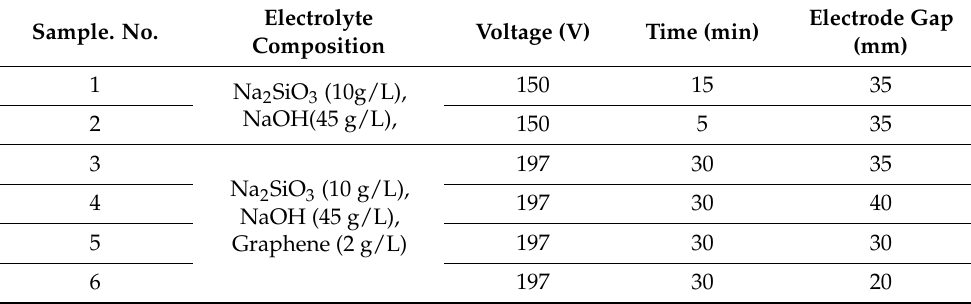
Table 3. Configuration of experiments. Sample.